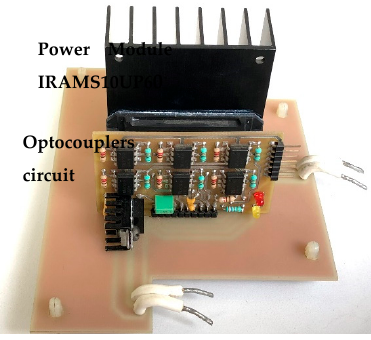
Figure 12. Electrical components of the experimental implementation of a CMLI cell with its drive circuit.